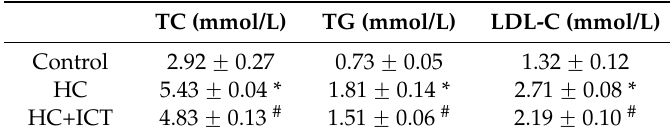
Table 1. Plasma lipids at the termination of